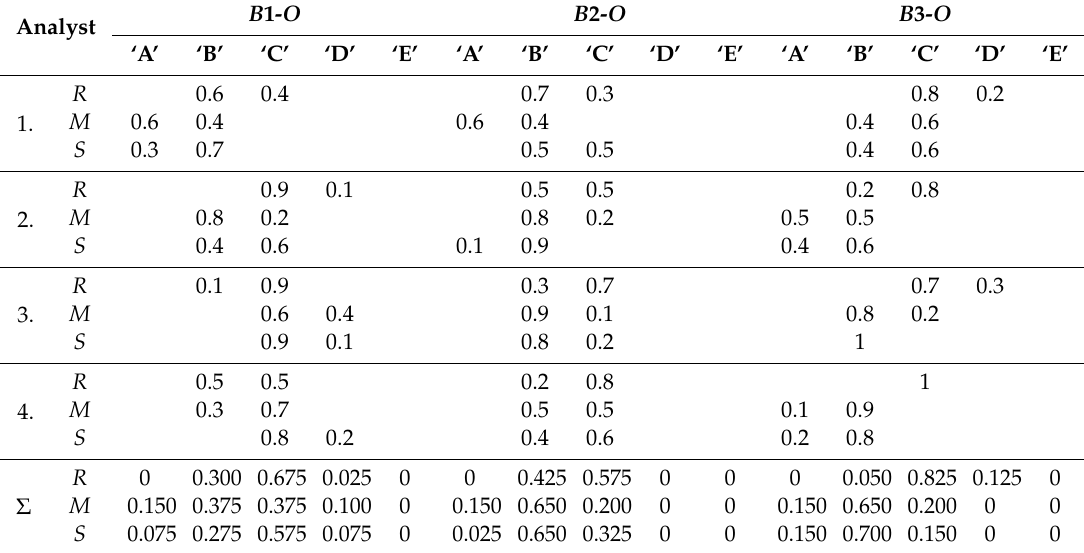
Table 5. Results of questionnaire for old machines.